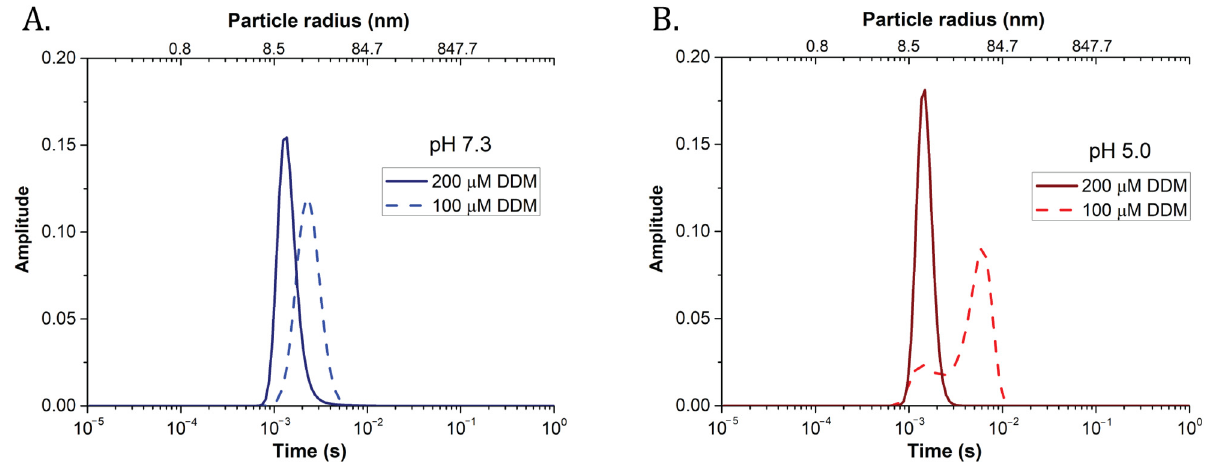
Figure 3. Maximum entropy FCS fitting method unveiled sample heterogeneity. Typical results obtained fitting FCS autocorrelation curves (see the Section 4) for samples prepared at 200 or 100 µM DDM, pH 7.3 ( A ), or pH 5.0 ( B ). The method allows for separating different diffusion components, highlighting possible size heterogeneity in LHCII clusters. The area below each trace was normalized to